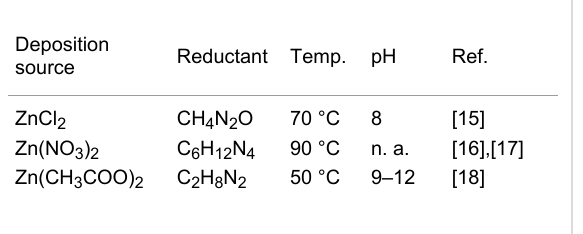
Reductant Temp. pH